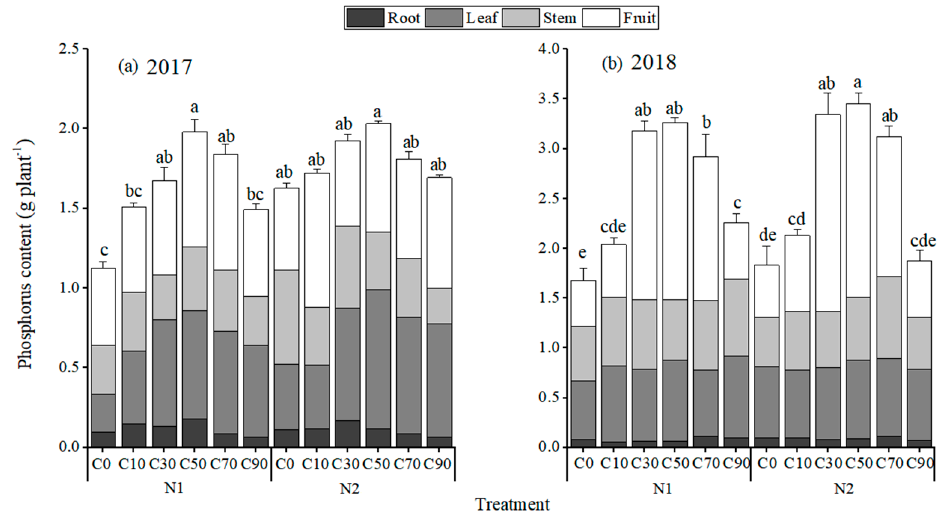
Figure 2. The effect of biochar on P uptake of tomato plants under low (N1) and normal (N2) nitrogen fertilization in 2017 ( a ) and 2018 ( b ). Different lowercase letters denote significant differences among treatment means at the 0.05 level by Duncan’s MRT method.